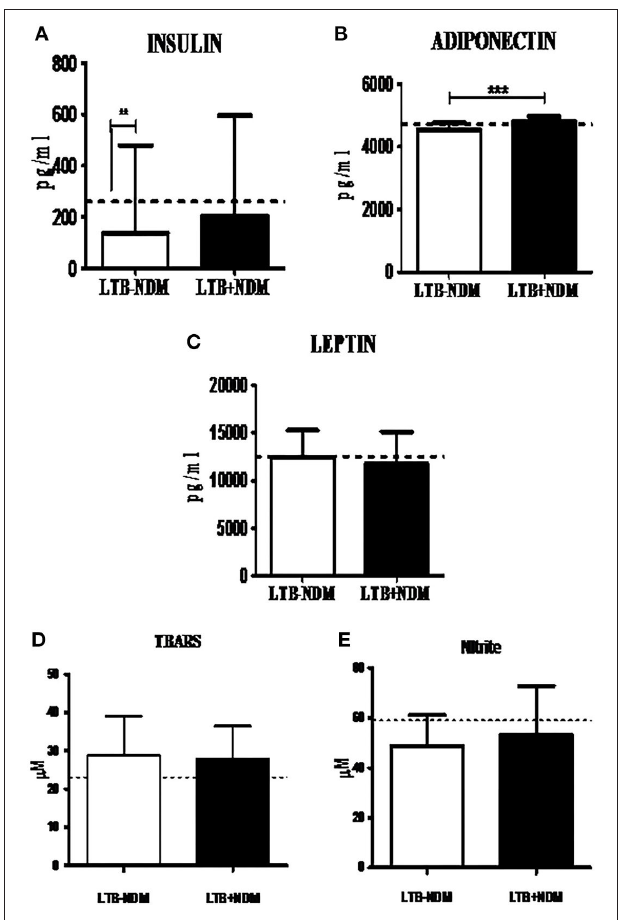
FIGURE 6 | LTBI increases Adiponectin levels in NDM subjects. The circulating levels of hormones and redox markers in PDM subjects were quantified by ELISA and colorimetry, respectively. Bar graph showing the circulating levels of Insulin (A) , Adiponectin (B) , Leptin (C) , TBARS (D) , and nitrite (E) levels in the serum of LTB-NDM ( n = 39) and LTB + NDM ( n = 39) subjects. The serum levels of TBARS and nitrites were quantified using colorimetry. The basal level, as was seen in LTB-NGT, is shown as dashed line (—-), as reference. Statistical significance was determined by non-parametric Mann–Whitney U -test and p < 0.05 was considered significant. * p < 0.05; ** p < 0.01 for LTB-NDM vs. LTB + NDM; ## p < 0.01 for LTB-NGT vs. LTB-NDM.